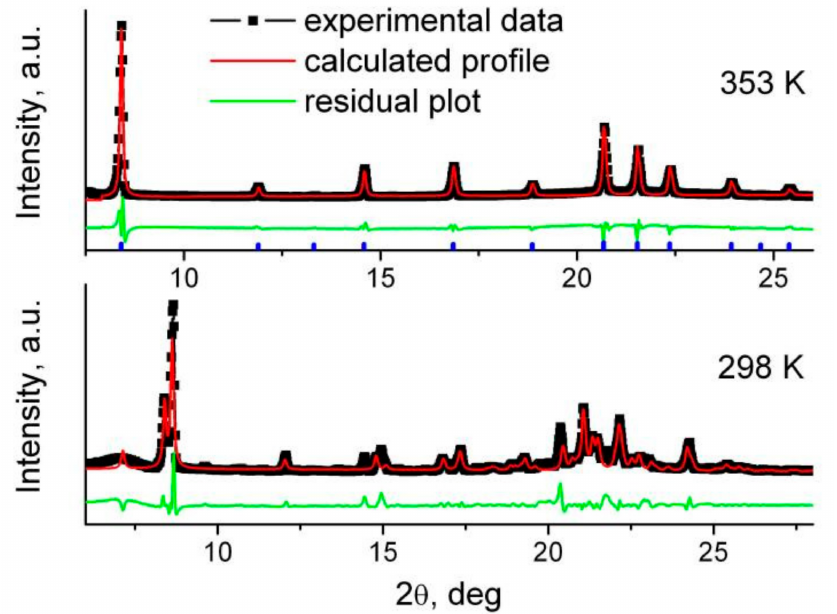
Figure 2. X-ray powder diffraction patterns of the LT and HT phases of TBAClO 4 recorded at 298 K and 353 K, lower and upper plots, respectively. The fitting curves and residual plots are also shown.